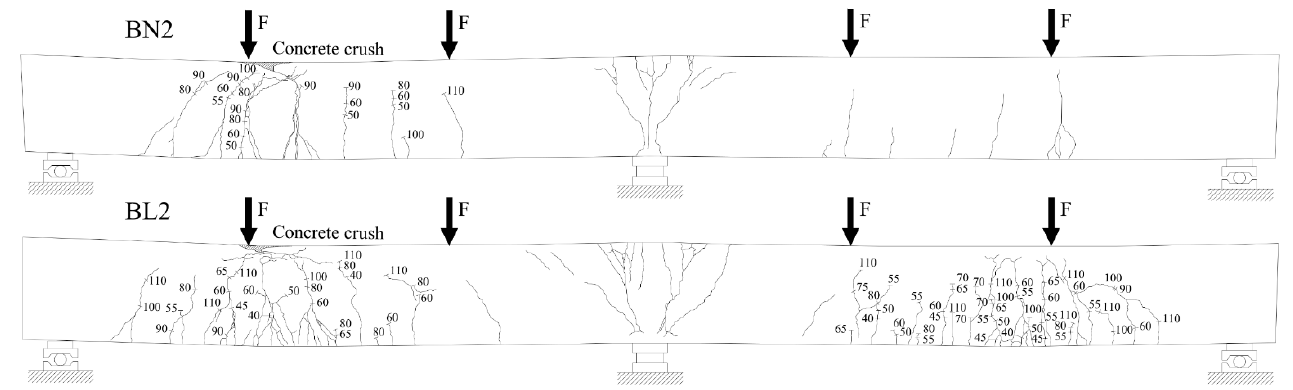
Figure 6. Crack propagation in BN1 and BL1 beams. Note: numerals given in figures indicate the applied load F (in kN). The drawings present the deformed beams after the removal of the load.